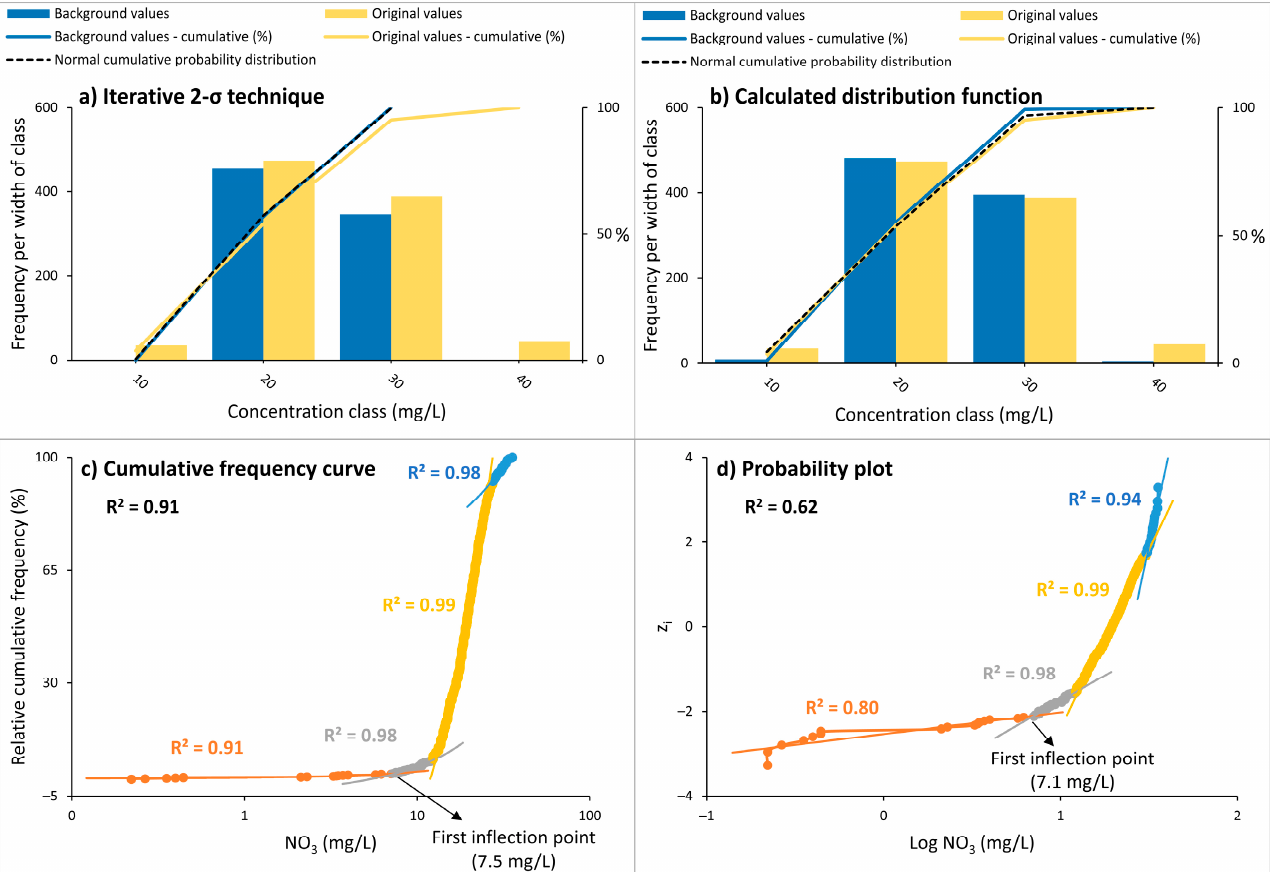
Figure 3. Four different methods to estimate ABV of nitrate for data without selection: ( a ) IT: lower background value: 11.8; D < D crit , ( b ) CDF: lower background value: 8.3; D > D crit , ( c ) CFC: background value: 7.5 and ( d ) PP: background value: 7.1. Arrow indicates first inflection point that separates background and non-background population.